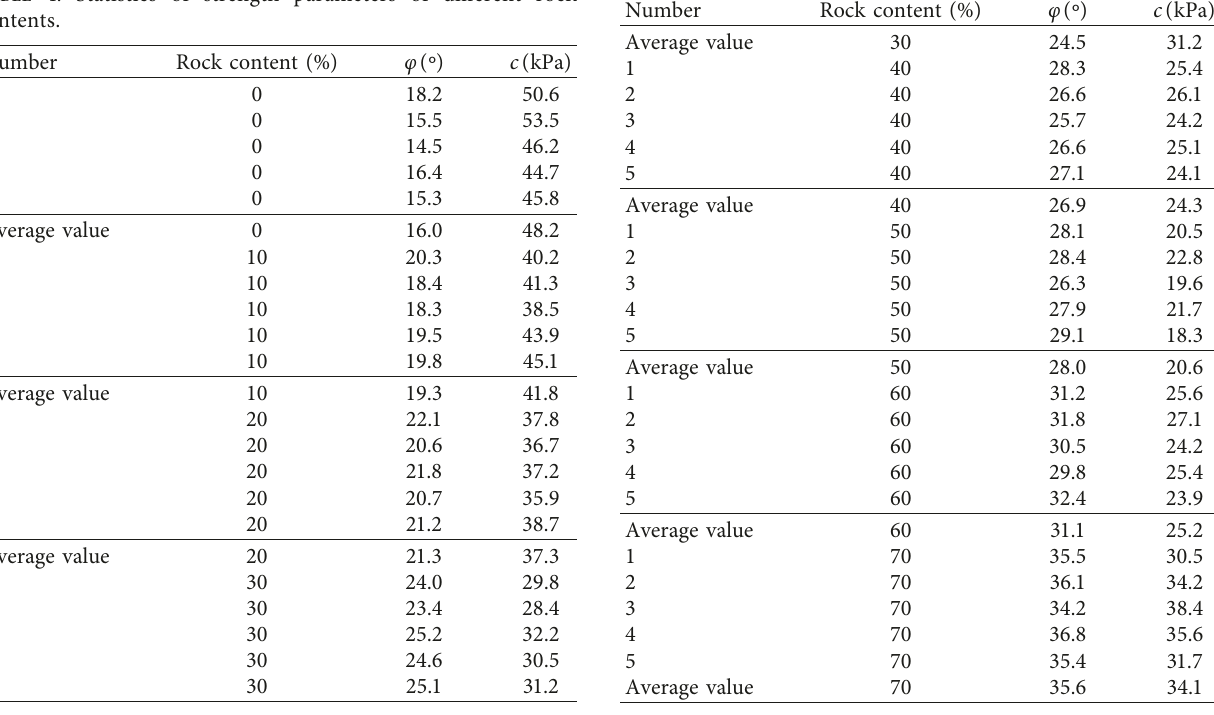
Figure 8: Models of different rock contents: (a) 0%, (b) 10%, (c) 20%, (d) 30%, (e) 40%, (f) 50%, (g) 60%, and (h) 70%. Table 4: Statistics of strength parameters of different